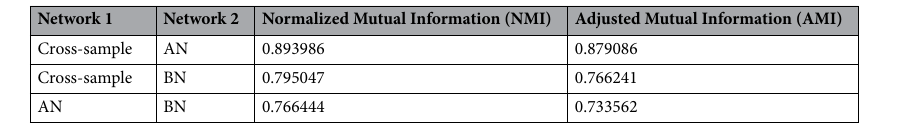
Table 5. Normalized and Adjusted Mutual Information score computed between all pairs of networks under study. Values range from 0 to 1, with 1 corresponding to perfect correlation.